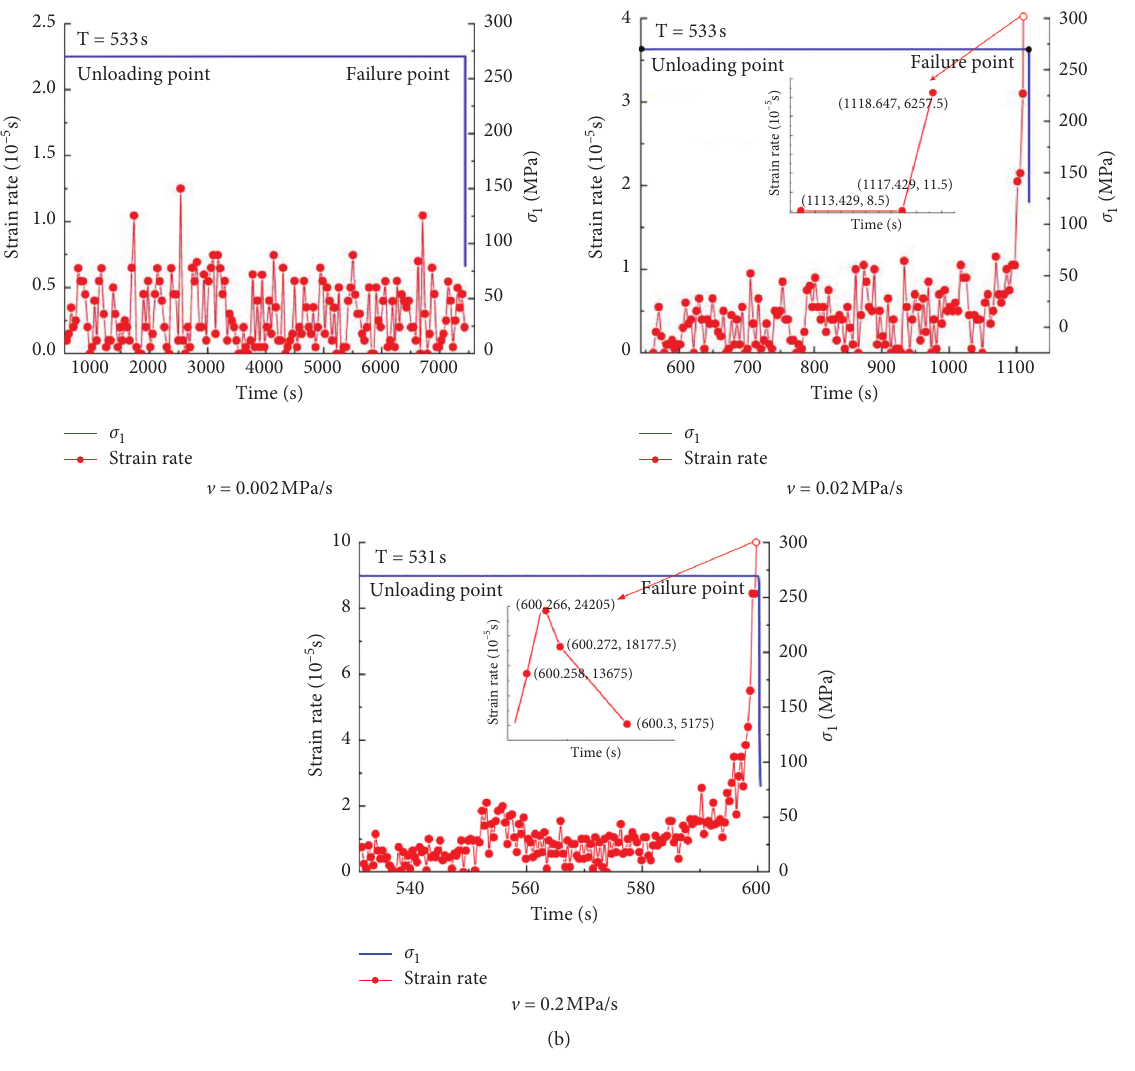
Figure 7: Variation of axial strain rate in the process of confining pressure unloading. (a) σ